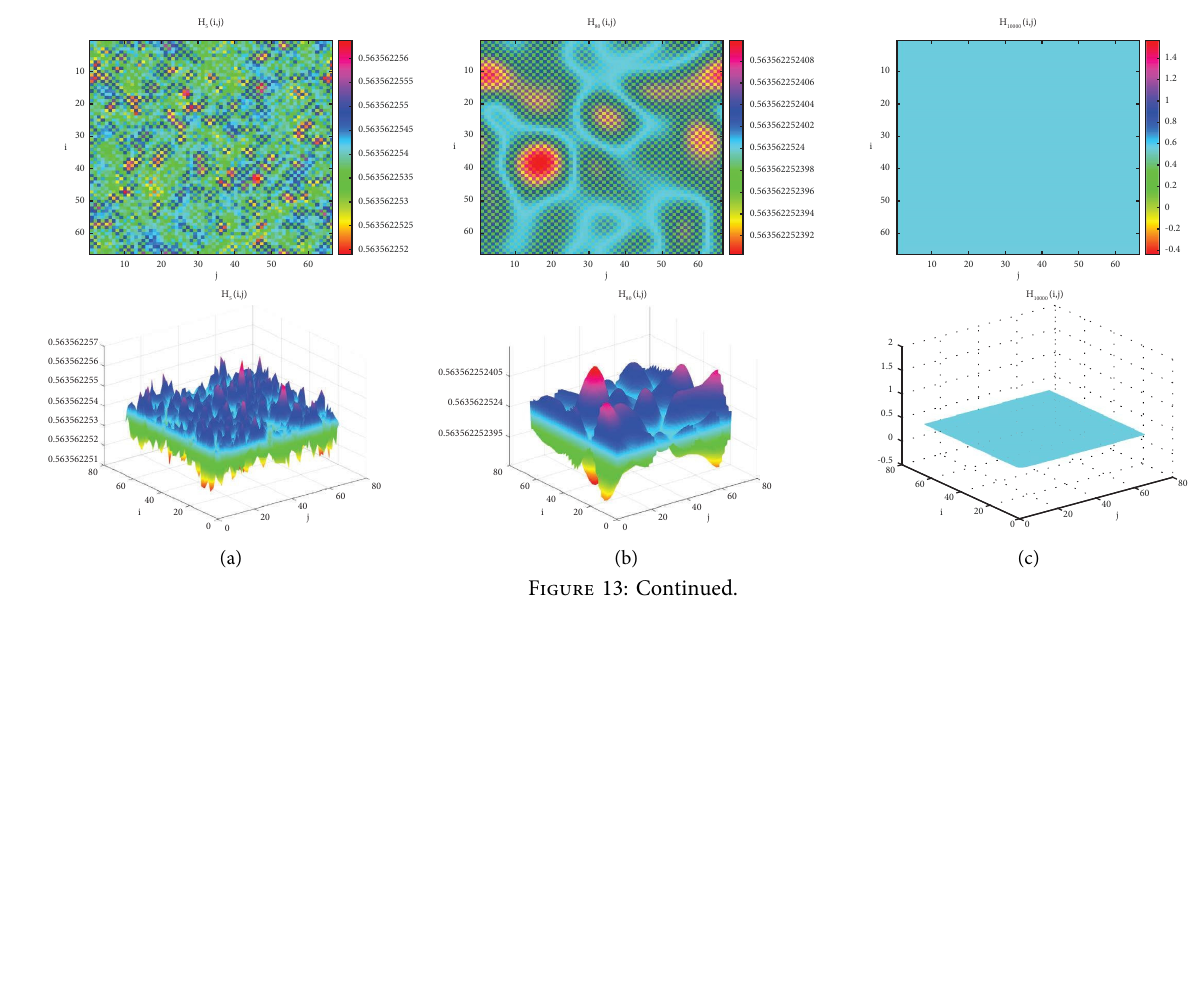
Figure 12: R � 2 ,k � 1, c � 0 . 8, σ ∗ � 0 . 278655, d the case of Corollary 3(2), the pure Turing instability occurs, parasite and host populations exhibit an extremely unstable state in two- dimensional